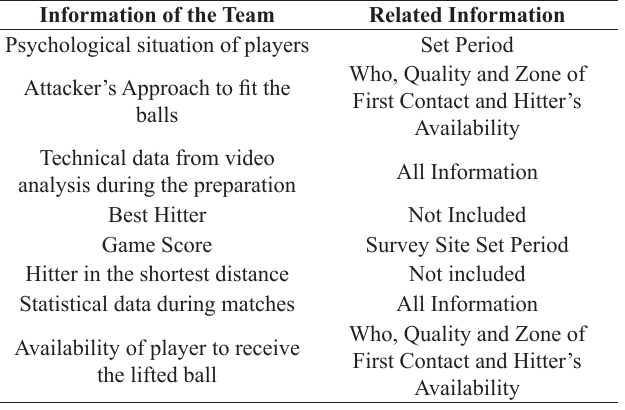
Table 4: List of information related to the opposing team comple- mented by the coaches with the information included in the question- naire during the Attack Processes.